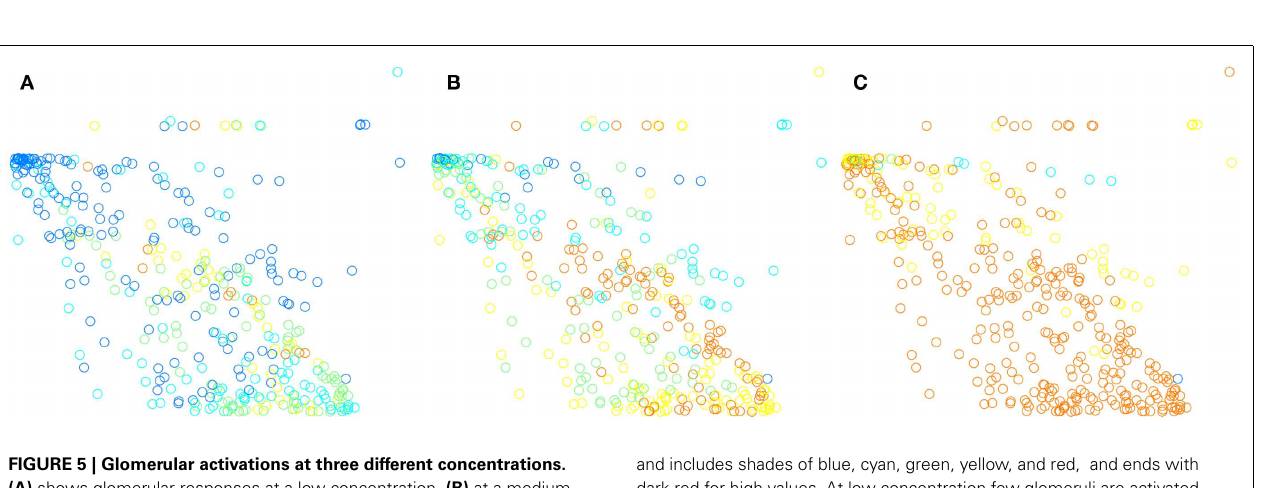
FIGURE 5 | Glomerular activations at three different concentrations. (A) shows glomerular responses at a low concentration, (B) at a medium concentration, and (C) at a high concentration. Plots are shown in two dimensions for clearer illustration (the actual space is in three dimensions).The color map starts from dark blue for small activations